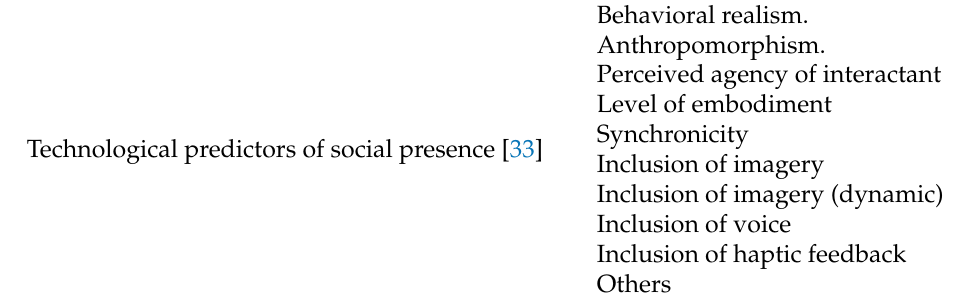
Table 1. Technological